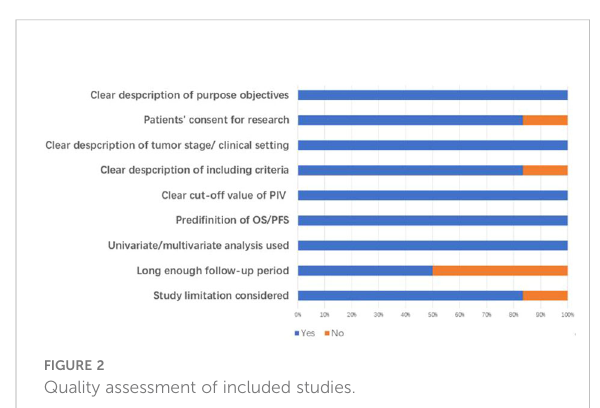
FIGURE 2 Quality assessment of included studies.